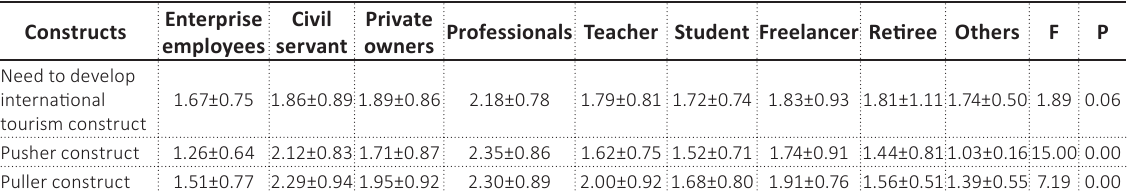
Table 10. Occupation difference